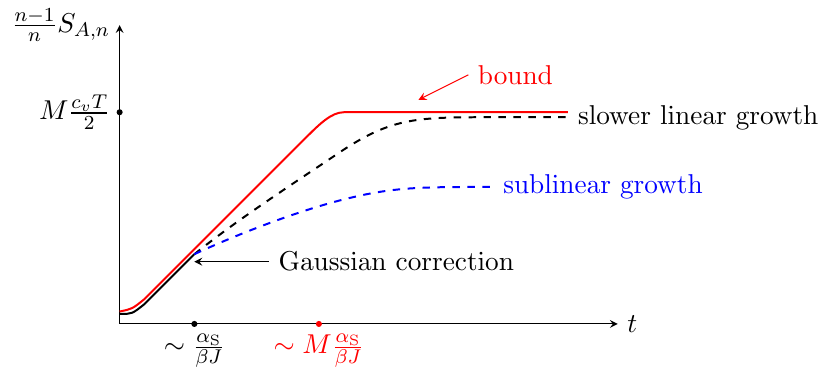
Figure 8 . A sketch of the possible entropy growth curve in a chain with M sites. The red line is the bound derived using the geometric interpretation with global/collective